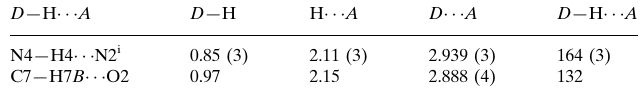
Hydrogen-bond geometry (A˚ , (cid:1)